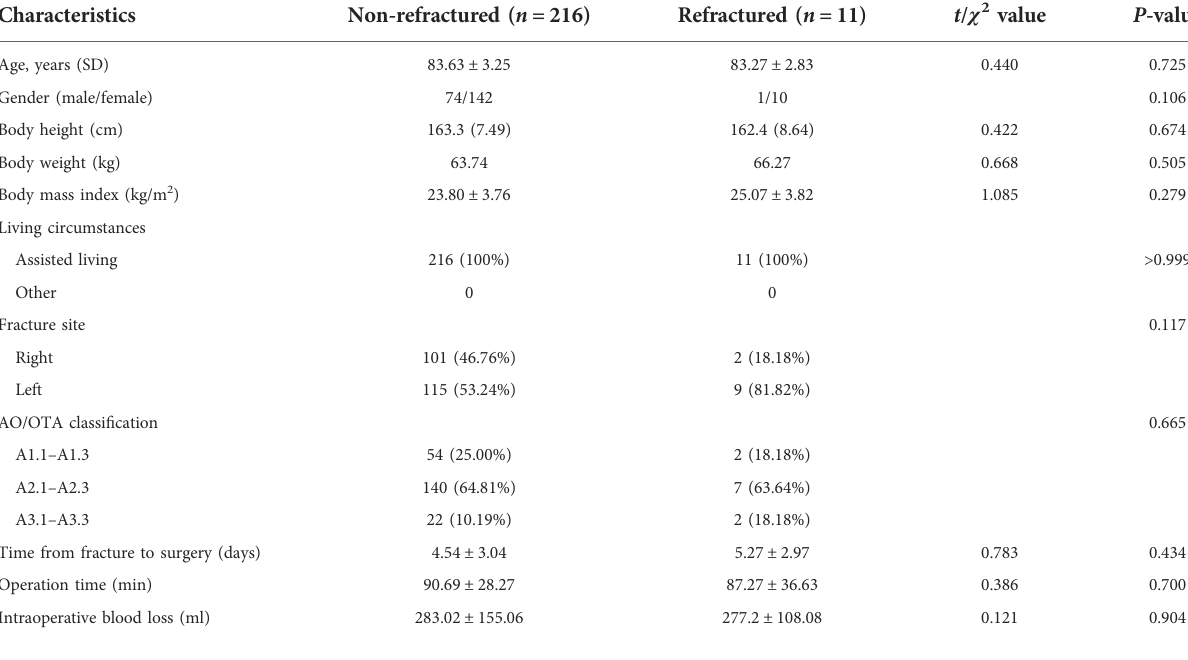
TABLE 1 Comparison of baseline data between the two groups.